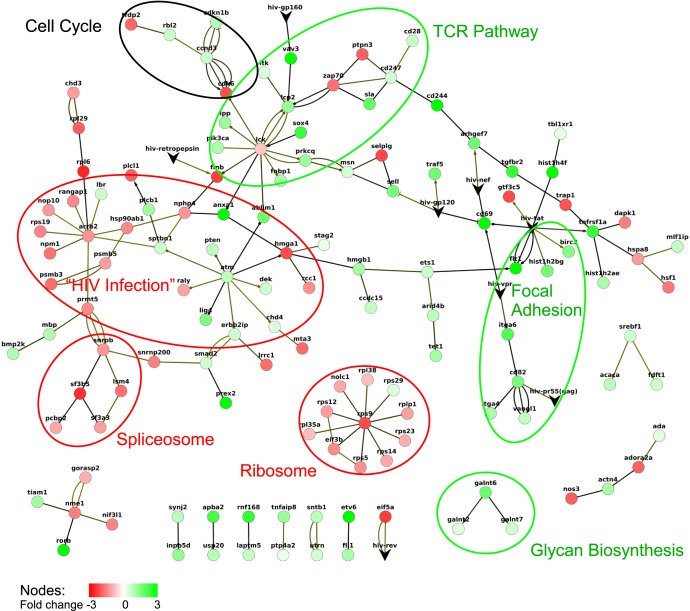
Response network of TSG and TDG.A response network was constructed based on RNA-seq data using a p-value cut off p = 0.01. The network consists of 138 nodes and 161 edges. Multiple edges between nodes indicate multiple evidence from different protein-protein interaction datasets ([Human Protein Reference Database] [Goel et al., 2011]; IntAct [Kerrien et al., 2012]; NetworKin, BHMRSS, CORUM, Hynet [Konig et al., 2010] and NCBIs HIV-1 interaction databases). Green and red nodes denote TSG and TDG, respectively. Edges are directional according to the respective databases. Edges with circles as ‘arrow tips’ denote phosphorylation reactions, ‘diamond shaped tips’ refer to general activation, and ‘arrows’ describe other reactions. Non-directional edges indicate binding. HIV, human immunodeficiency virus; RNA-seq, RNA sequencing; TDG, Tat downregulated genes; TSG, Tat stimulated genes.